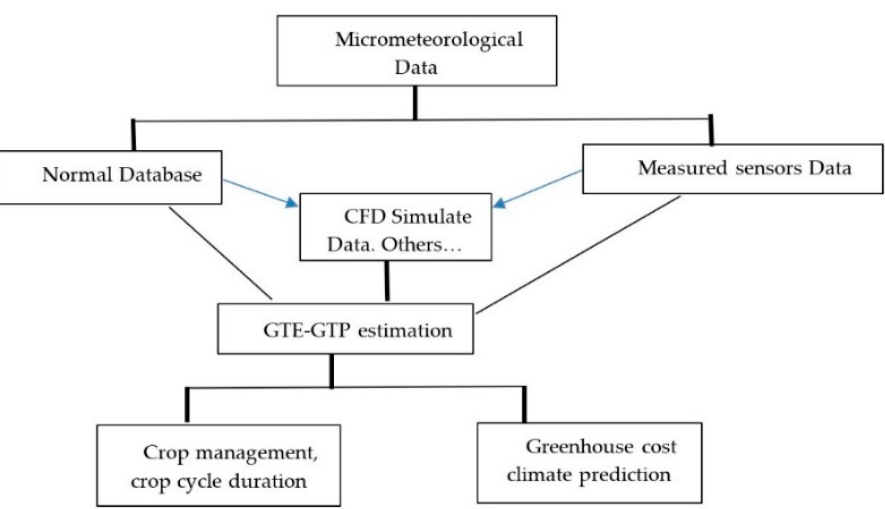
Figure 1. Logical process to estimate the thermal Figure 1. Logical Process to estimate the thermal index.